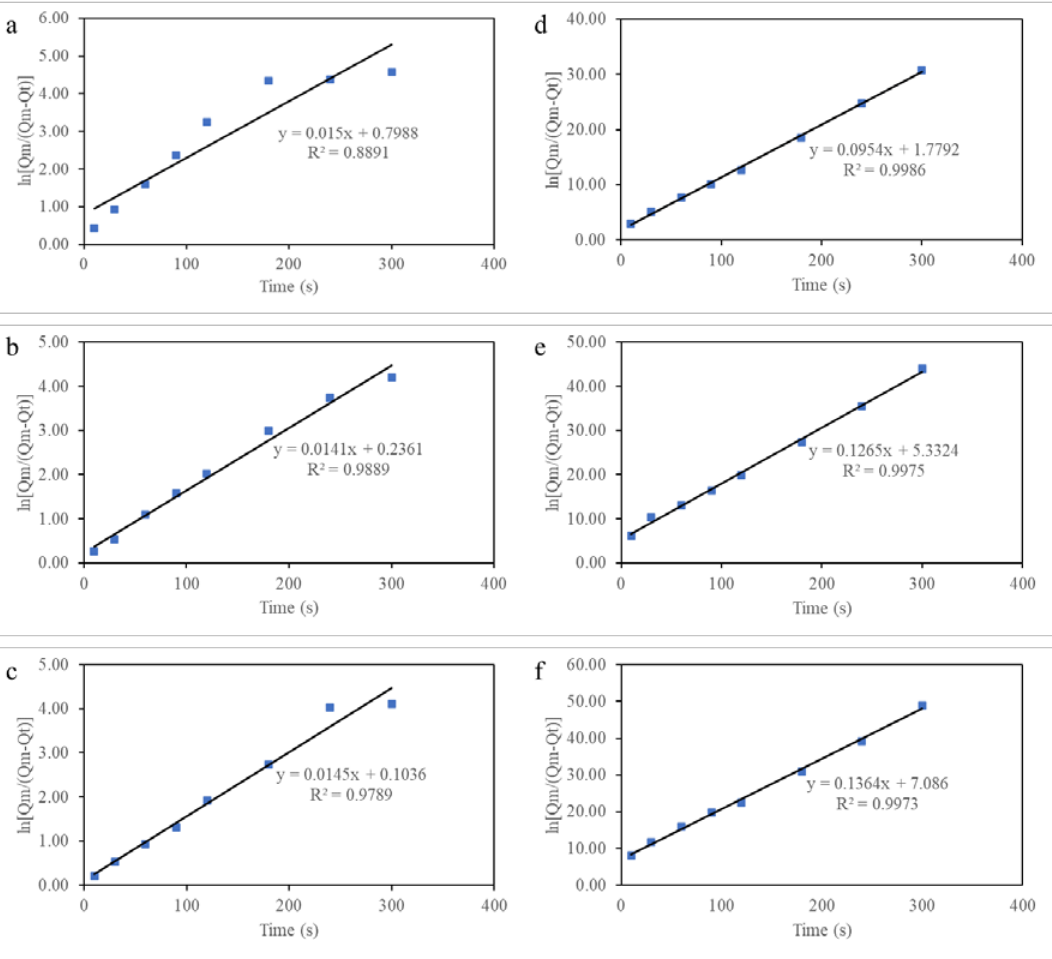
Figure 10. Pseudo - first - order ( a – c ) and pseudo - second - order ( d – f ) absorption linear fitting of Mobil 1 5W - 50 oil on AAs with varying aluminum content (4, 6 , and 8 wt.% ,